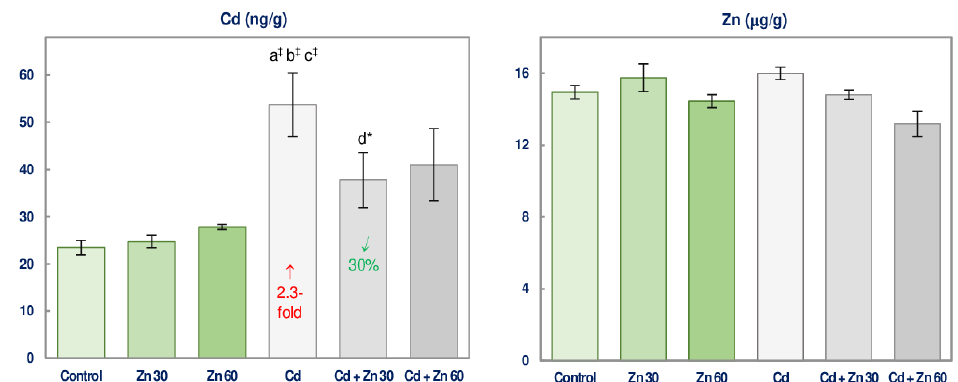
Figure 7. The concentrations of cadmium (Cd) and zinc (Zn) in the brain tissue of male rats after 6-month treatment with 5 mg Cd/L and/or 30 or 60 mg Zn/L via drinking water. Data are shown as mean ± standard error (SE) for 8 animals. Statistically significant differences: a vs. Control group; b vs. Zn 30 group; c vs. Zn 60 group; d vs. Cd group; * p < 0.05; ‡ p < 0.001. The values inside the bars express the percentage change or a fold of change vs. the control group ( ↑ , increase) or Cd group ( ↙ , decrease).